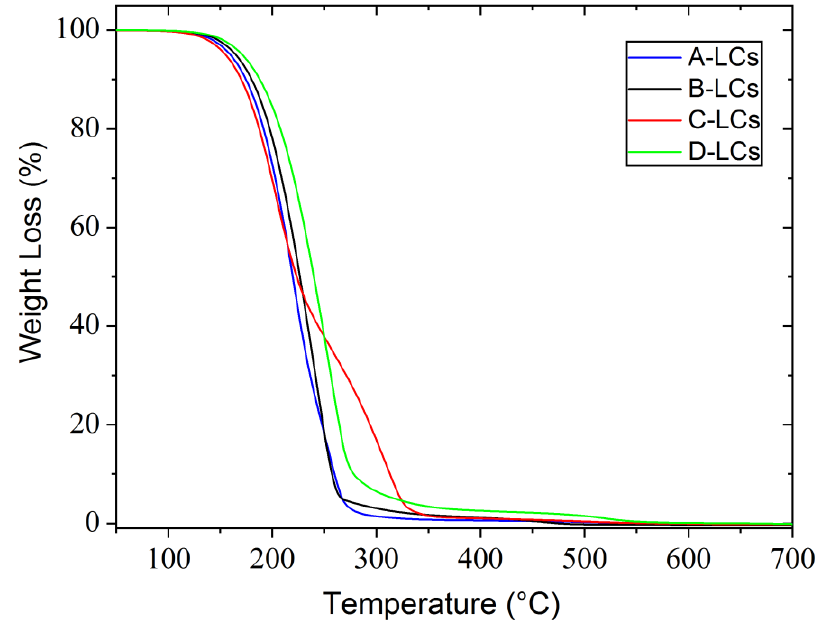
Figure 10. TGA results from LC mixtures of EOL-LCDs A, B, C and D.